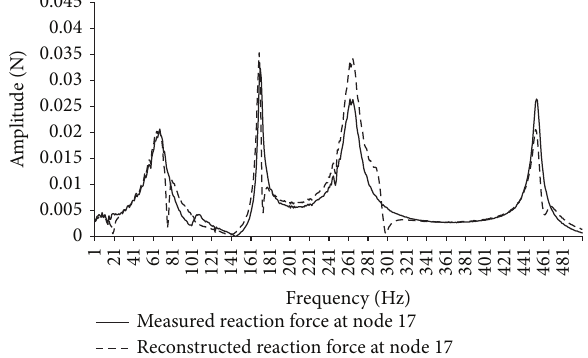
Figure 11: Experimental and estimated force reaction 𝐹 17 .